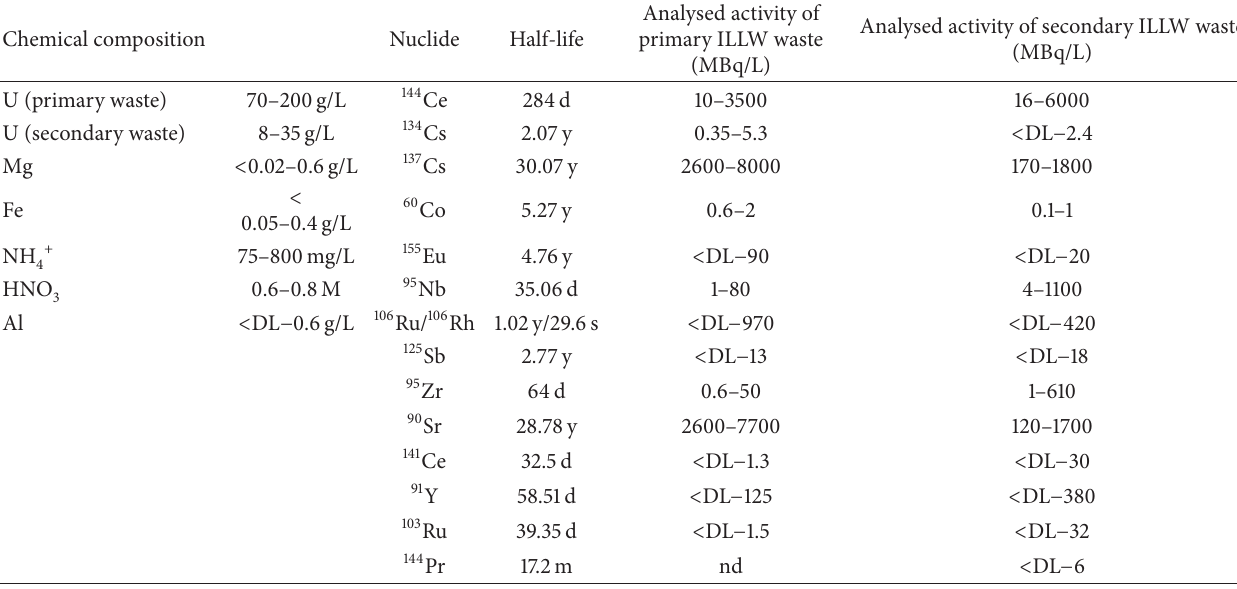
target produced at ANSTO . 2